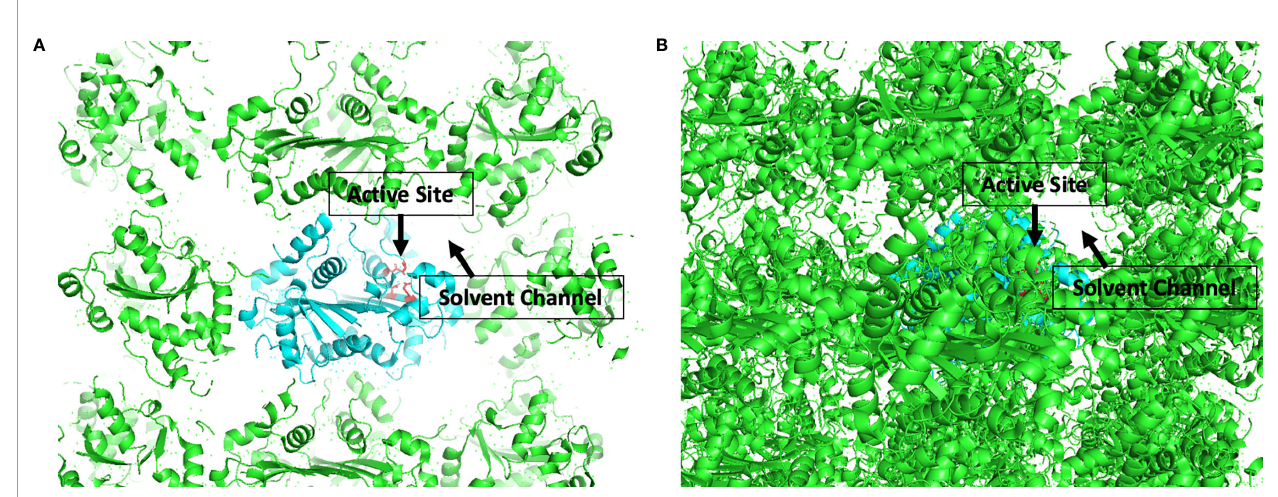
FIGURE 7 | Active Sites are Accessible by Solvent Channel in TREX1 Apoenzyme Crystals. Structural representation of crystal lattice for mTREX1(1-242) apoenzyme crystal. Functional unit of interest is colored cyan with DEDD active site residues for one protomer shown as red sticks; other functional units are colored green. Graphic (A) is a slice through the crystal lattice where the active site is visibly facing the solvent channel, and graphic (B) looks through the solvent channel into the crystal lattice. Alignment and graphic were generated in PyMOL using the PDB structure 3MXJ from ref